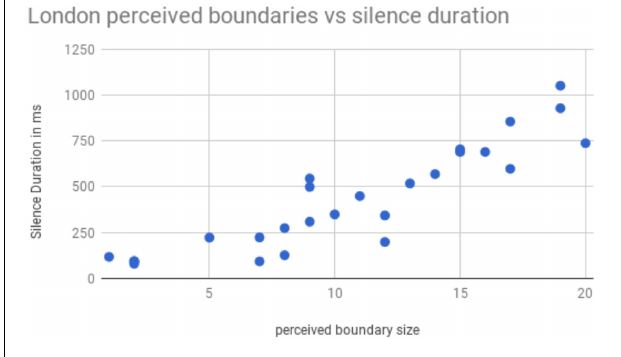
FIGURE 3 | Perceived boundary size, as determined by the number of boundary markers inserted by listeners, shown as a function of the duration of silence between word